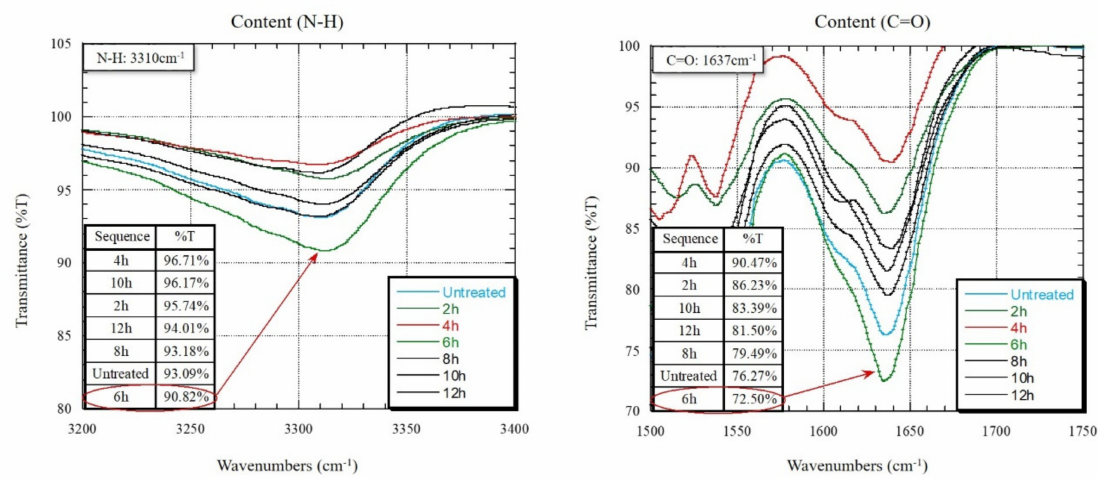
Figure 6. FT-IR analysis of ZnCl 2 surface-treated aramid fabrics in various processing